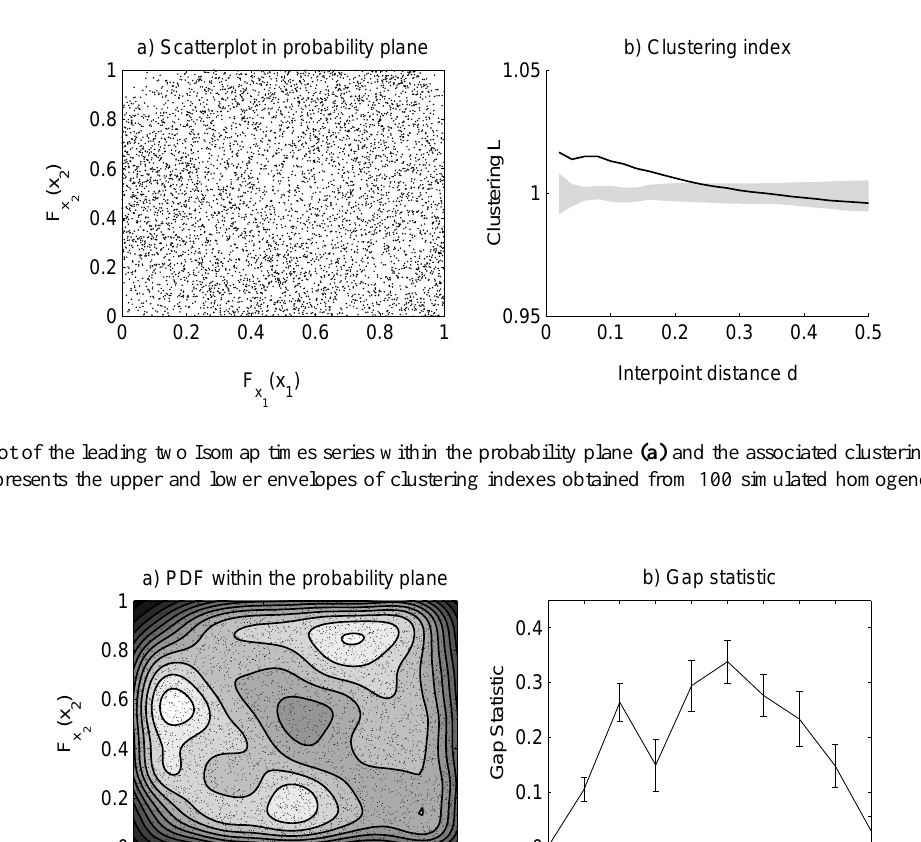
32 Fig. 9. Kernel PDF estimate of the leading two Isomap time series within the probability plane (a) and the gap statistic (b) . The vertical bars in (b) refer to one standard deviation above and below the gap statistic based on the homogeneous Poisson point process null hypothesis (see text for